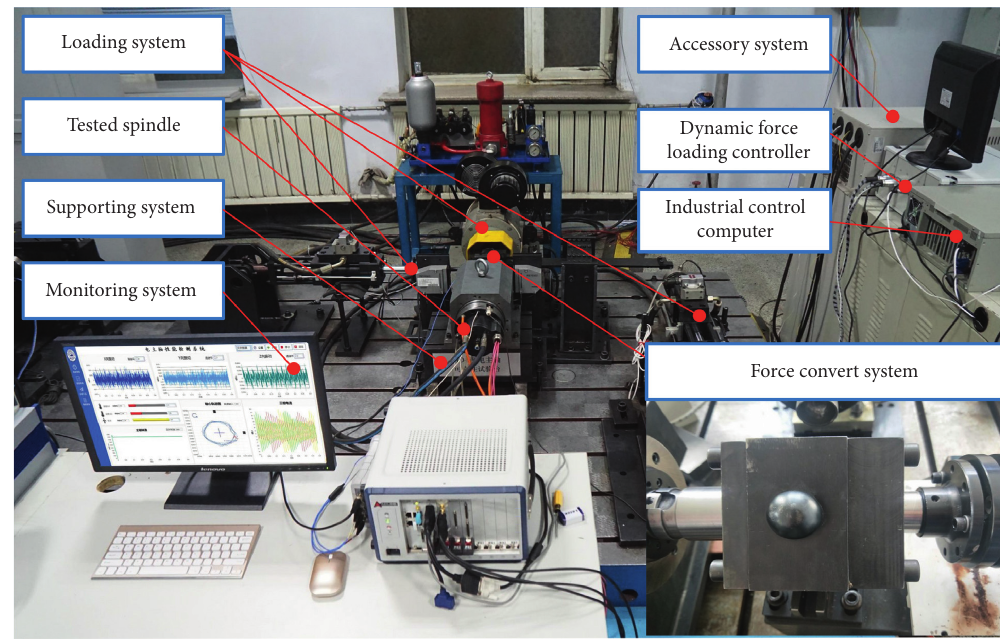
Figure 3: The mechanical structure of the